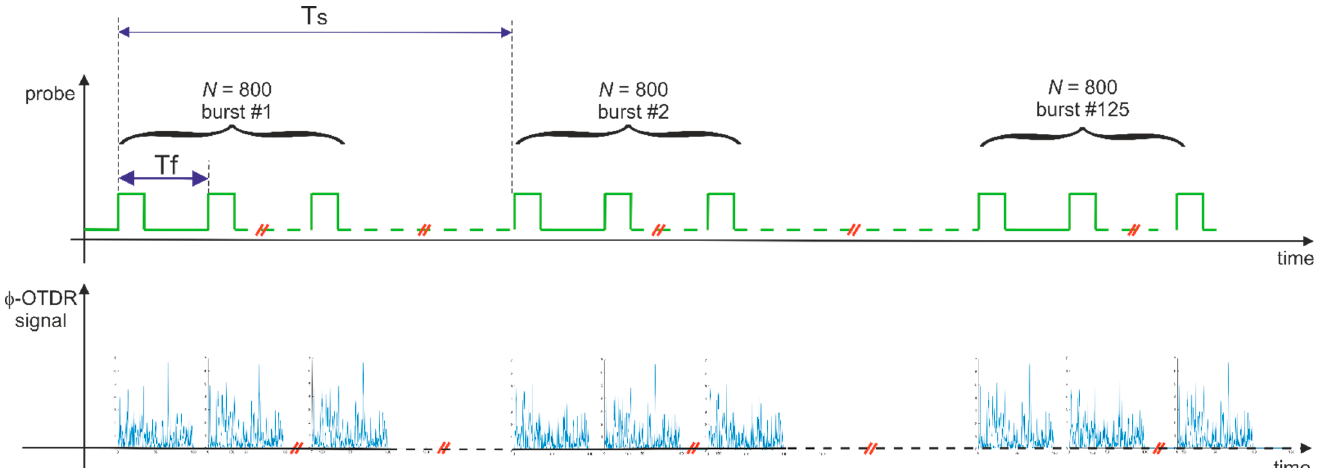
Figure 4. Time scales of the φ -OTDR measurements. T f represents the repetition of the pulses used to capture the acoustic response of the fiber, while T S represents the repetition period of the tone bursts used to excite the Lamb waves in the aluminum plate. The red diagonal lines along the horizontal axes represent time gaps.